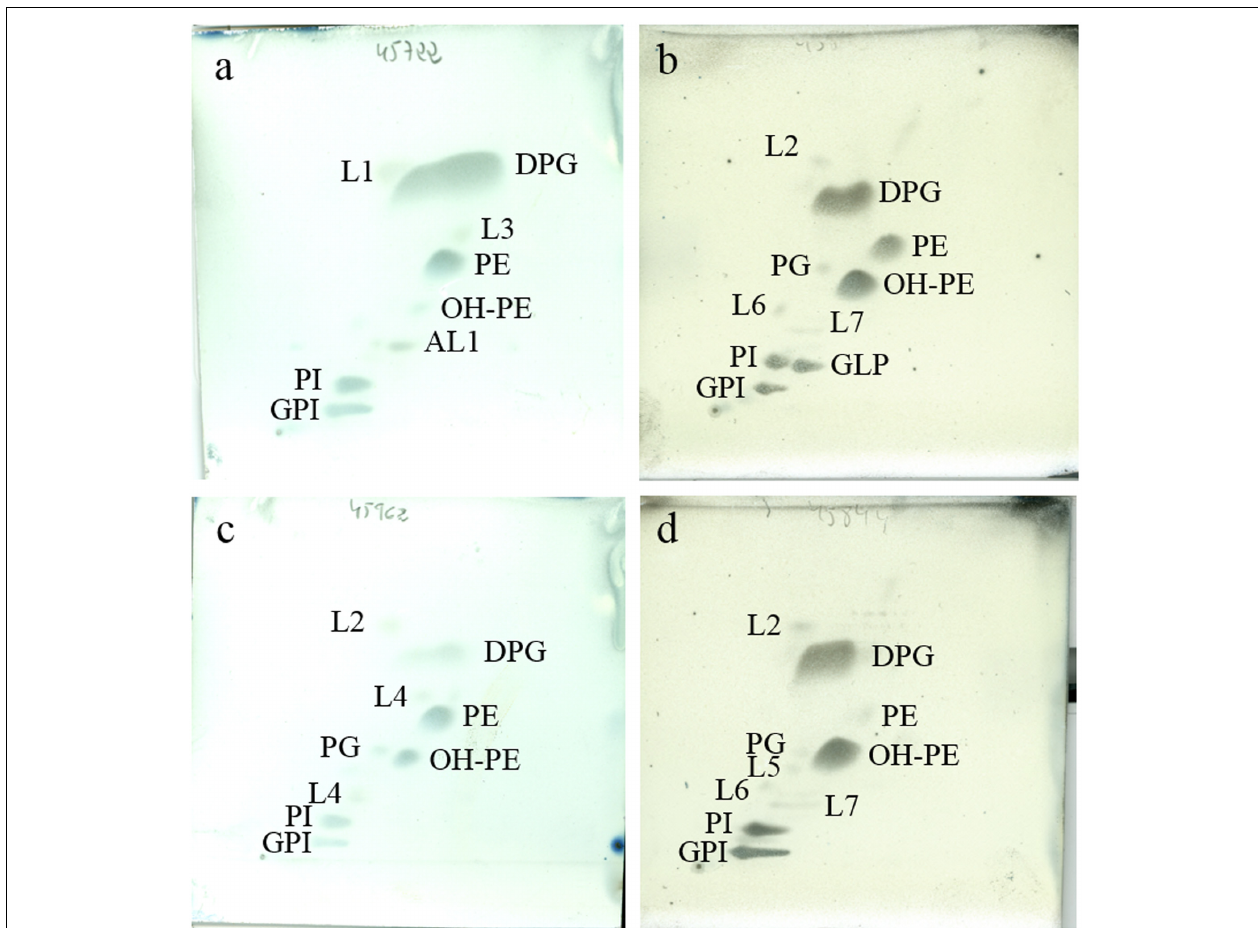
FIGURE 3 | Polar lipids profile of strain YIM M13156 T (a) , G. soli DSM 45843 T (b) , G. taihuensis DSM 45962 T (c) and G. terrae DSM 45844 T (d) after separation by two-dimensional TLC using the solvents chloroform:methanol:water (65:25:4; v:v:v) in the first dimension and chloroform:methanol:acetic acid:water (80:12:15:4; v:v:v:v) in the second one. Plates were sprayed with molybdatophosphoric acid (3.5%; Merck TM ) for detection of the total polar lipids. DPG, diphosphatidylglycerol; PG, phosphatidylglycerol; PE, phosphatidylethanolamine; OH-PE, hydroxyphosphatidylethanolamine; PI, phosphatidylinositol; GPI, glycophosphatidylinositol; GPL, unidentified glycophospholipid; AL, aminolipid; L1-7, unidentified lipids. All data are from this